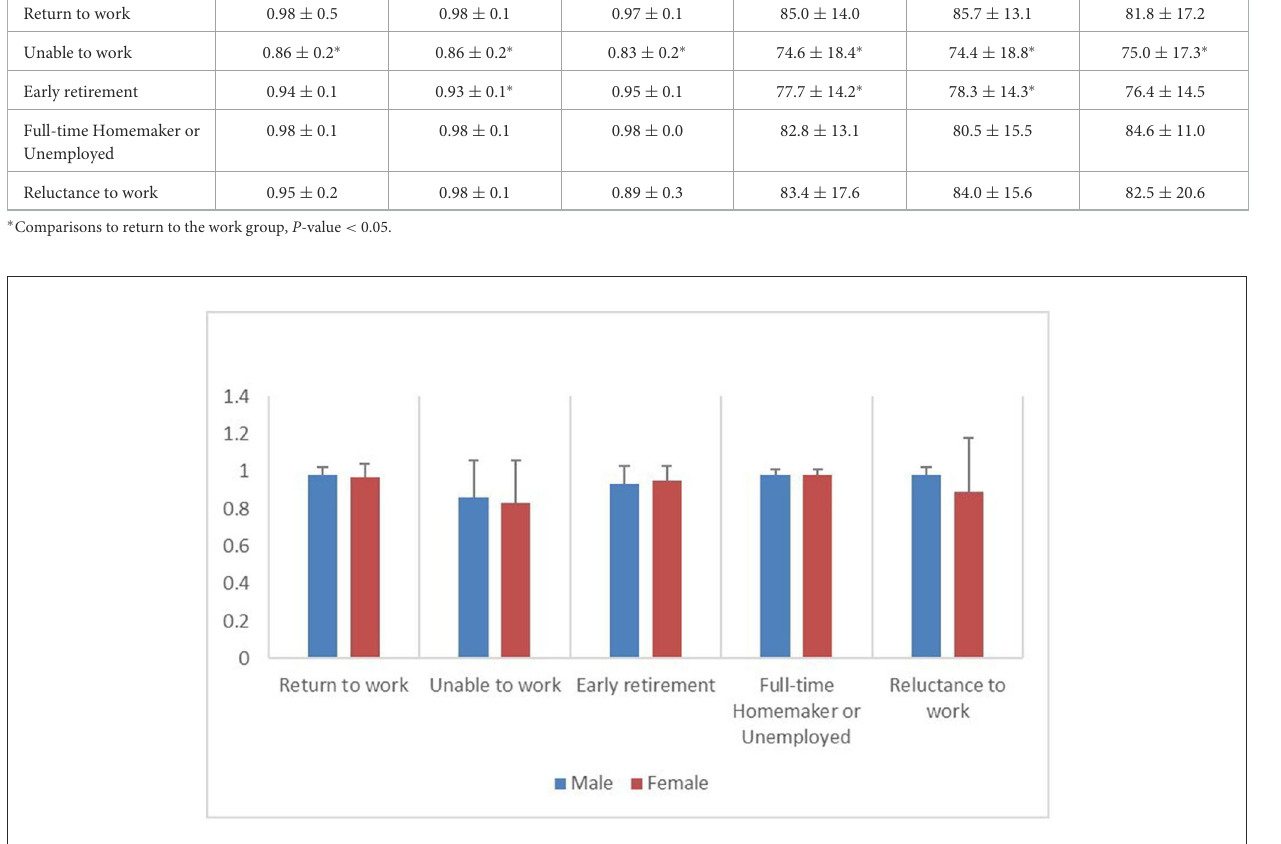
FIGURE4 Distribution of EQ-5D index among patients who have returned to work and the four groups of patients who have not returned to work, stratified by